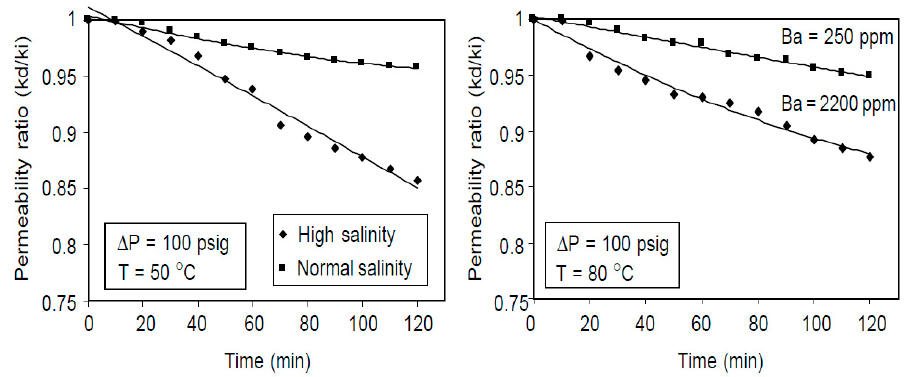
Figure 4. Permeability decreases in time for different temperatures and barium concentration values [22].